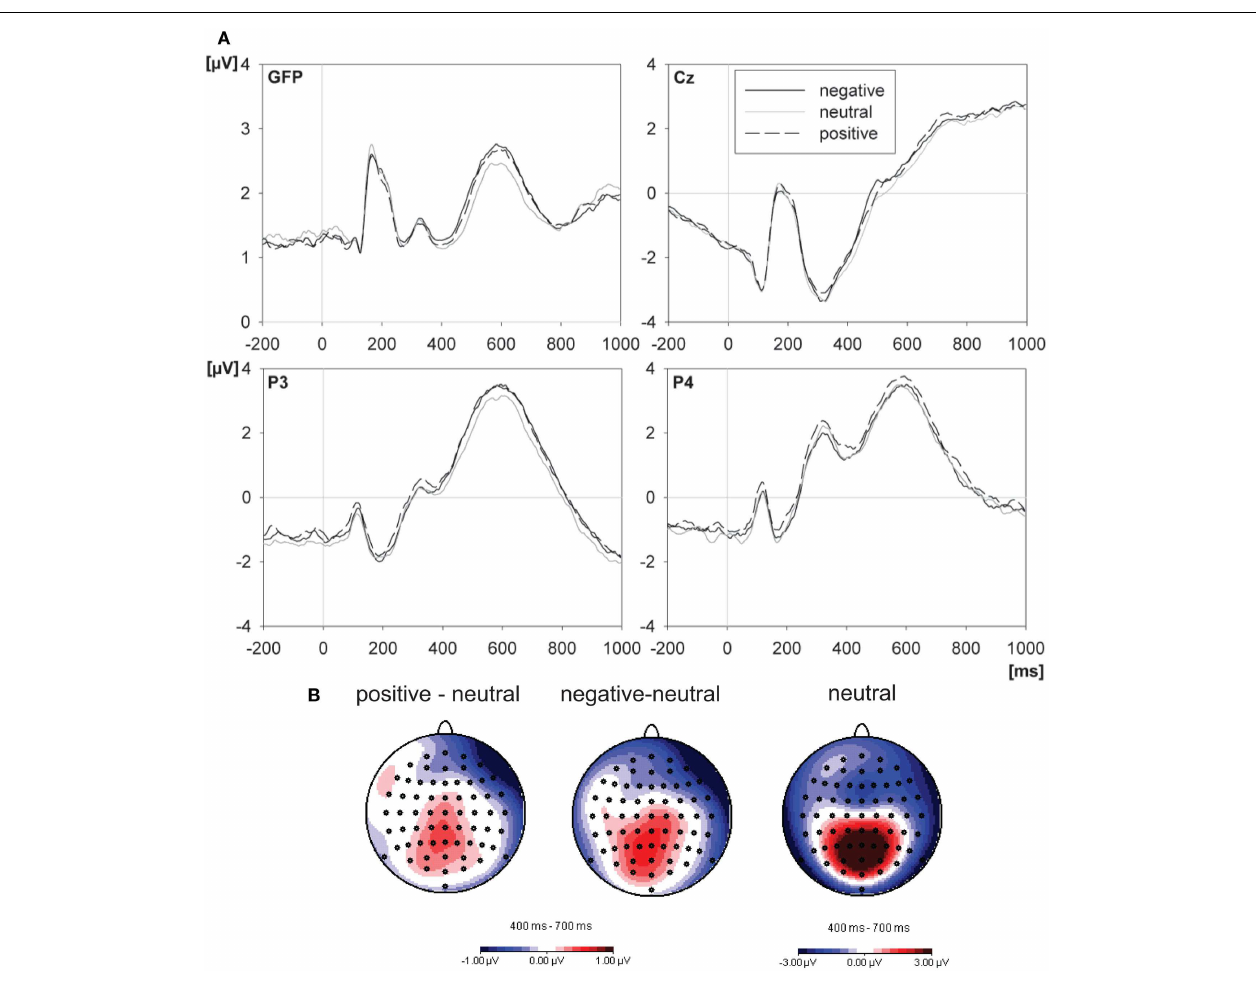
the scalp distributions (standard amplitude subtraction) of the differences between positive and neutral words and between negative and neutral words and, further, the distribution of ERPs to neutral words within the 400–700-ms interval after the